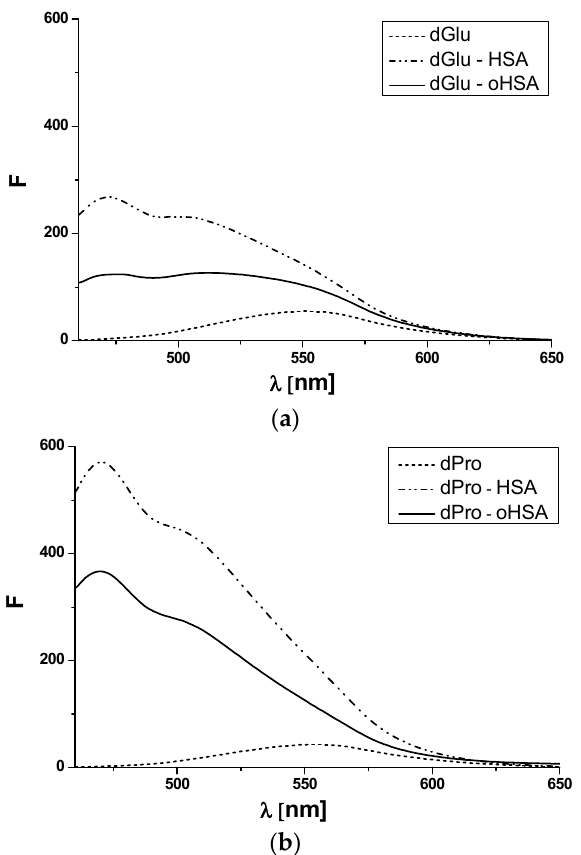
Figure 6. Emission fluorescence spectra of ( a ) dGlu and ( b ) dPro in the presence of HSA and oHSA. [dGlu] = [dPro] 5 × 10 − 5 mol · L − 1 , [HSA] = [oHSA] 1 × 10 − 5 mol · L − 1 ; λ ex = 350 nm. Fluorescent label dGlu binds to the IIA subdomain of HSA molecules while dPro to HSA IIIA subdomain [46,47]. This phenomenon has been confirmed by the analysis of dGlu (Figure 6a) and dPro (Figure 6b) fluorescence spectra. The binding with HSA and oHSA causes a shift towards short wavelengths of dGlu ( ∆ λ 21 nm, ∆ λ 26 nm) and dPro ( ∆ λ 16 nm) spectra and confirms the location of both probes in albumin hydrophobic regions. Due to the changes in dGlu and dPro fluorescence excited at 350 nm in the presence of HSA and oHSA, dGlu-human serum albumin binding in the IIA subdomain and dPro-human serum albumin binding in the IIIA subdomain have been studied. Using the data collected from the fluorescence spectra of dGlu-HSA and dPro-HSA complexes (data not shown), association constants K a [mol − 1 · L] have been calculated (Figure 7). As has been calculated, association constants for dGlu-HSA and dGlu-oHSA system equal to K a = 5.47 × 10 4 ± 0.62 × 10 4 mol · L − 1 (n = 0.86 ± 0.01) and 6.02 × 10 4 ± 2.12 × 10 − 10 mol · L − 1 (n = 0.99 ± 0.01), respectively (Figure 7a). The slightly higher value of dGlu association constant in the presence of oHSA compared to HSA indicates that the oxidation process changed the IIA subdomain of albumin, however, the change in the K a value is small and points to non-significant modifications. Similarly as in our previous study [26], the Scatchard plots obtained for both dPro-HSA and dPro-oHSA systems are not straight lines (Figure 7b). It probably means that there are more than one binding site for dPro in HSA and oHSA subdomains. The association constants K a [mol · L − 1 ] obtained for two binding sites were determined using the non-linear regression method (Figure 7, in the insert, r 2 = 0.99) based on the Levenberg–Marquardt algorithm (OriginPro 8.5 SR1 software). By the analysis the association constants values calculated for dPro- HSA (K a1 = not achievable, n 1 = not achievable, K a2 = 1.21 × 10 4 ± 0.58 × 10 4 mol · L − 1 , n 2 = 0.95 ± 0.25) and dPro-oHSA (K a1 = 1.71 × 10 4 ± 2.80 × 10 4 mol · L − 1 , n 1 = 0.49 ±